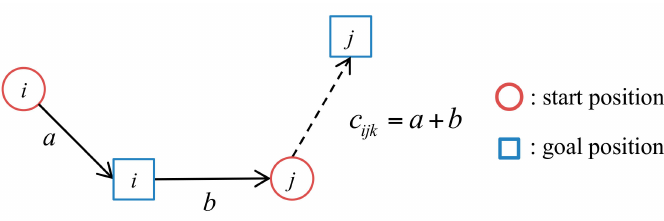
Figure 2. Definition of the cost c ijk between tasks i and task j